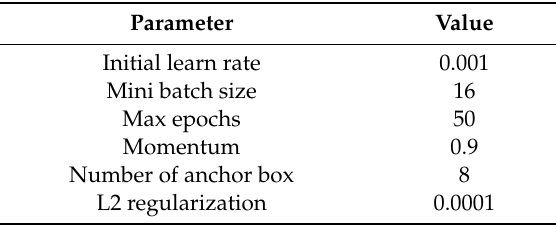
Table 2. Parameters for training the YOLO v2 detector. The optimizer was the aforementioned stochastic gradient decent (SGD) with momentum.